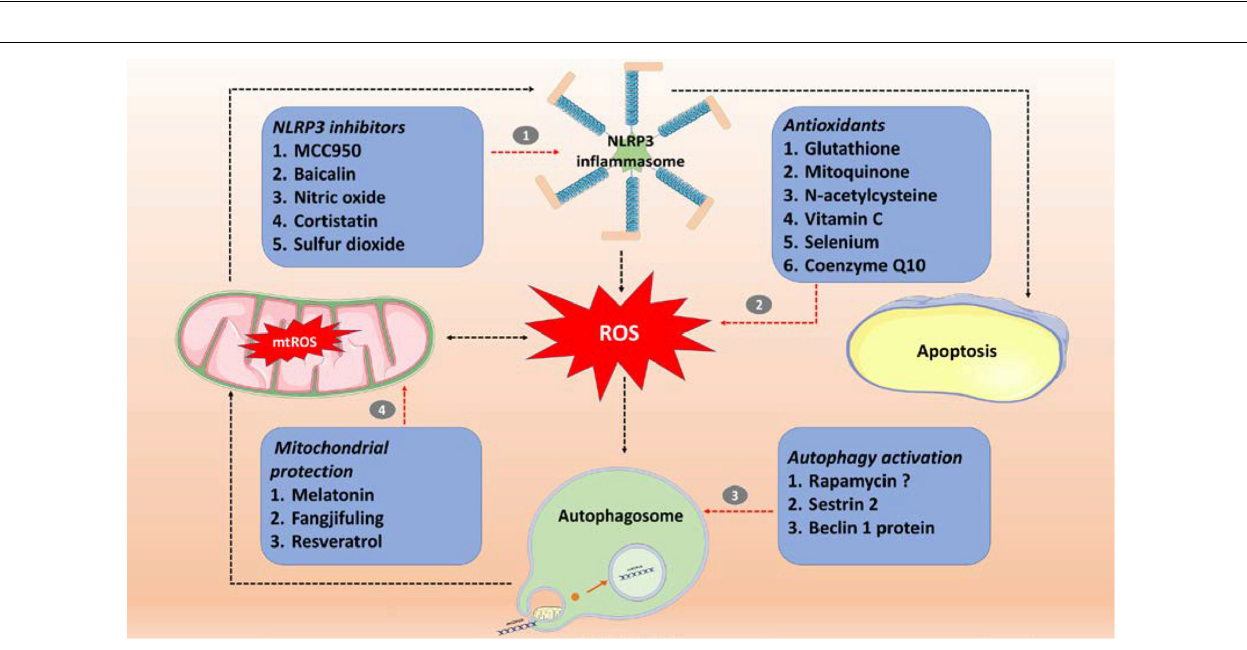
FIGURE 2 | Sepsis treatment involves targeting the ROS/NLRP3-centered inflammatory pathway. (1) Specific inhibitor (MCC950) and non-specific inhibitors (baicalin, nitric oxide, cortistatin, and sulfur dioxide) of NLRP3 inflammasomes; (2) antioxidants (glutathione, mitoquinone, N -acetylcysteine, vitamin C, selenium and coenzyme Q10); (3) autophagy activators (rapamycin, SESN2, and beclin 1 protein); (4) mitochondrial protection (Fangjifuling and resveratrol). ROS, reactive oxygen species; mtROS, mitochondrial reactive oxygen species; NLRP3, NOD-, LRR-, and pyrin domain-containing protein 3.